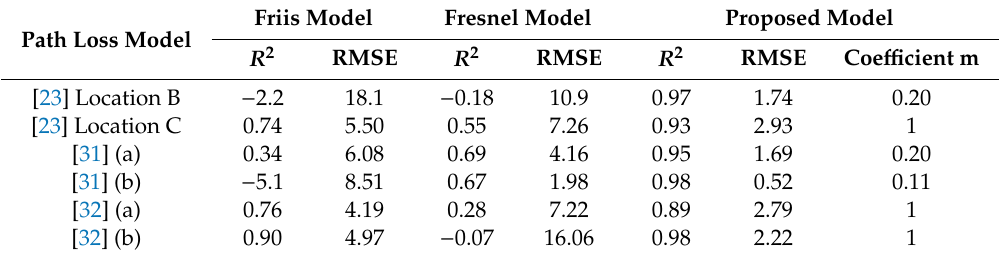
Figure 10. Comparison of the propagation models with experiment data from the literature [23]. ( a ) location B; ( b ) location C. Table 5. R 2 and RMSE of the propagation models fitting the experiment data from the